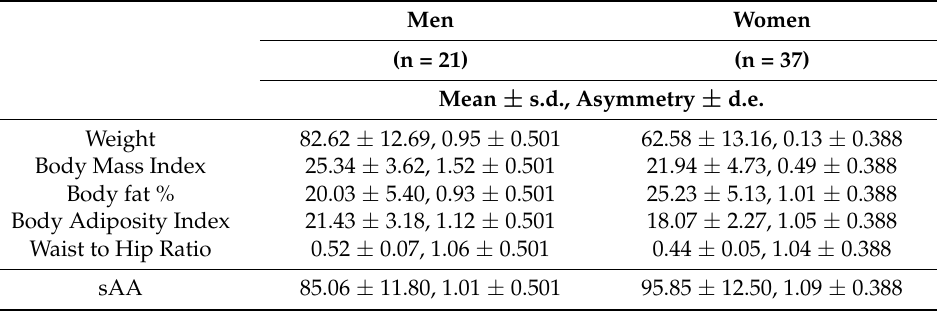
Table 1. Anthropometric measures and sAA in men and